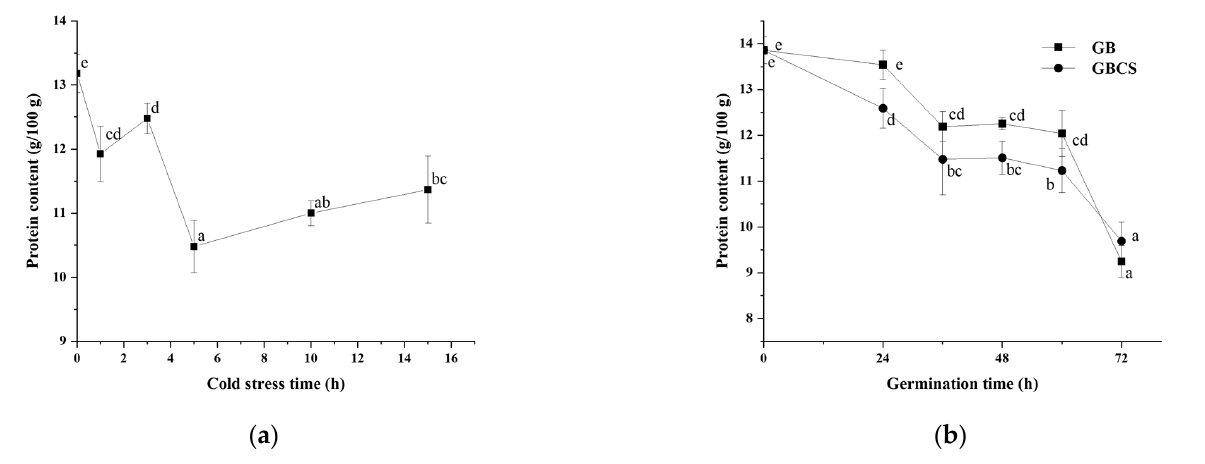
Figure 6. Change in protease activity in fl uenced by cold stress and germination. GB, germinated black rice grain without cold stress; GBCS, germinated black rice grain under cold stress at 0 °C for 1 h; ( a ) represents the change in protease activity in fl uenced by cold stress time; ( b ) represents the change in protease activity in fl uenced by germination time with or without cold stress. Means with